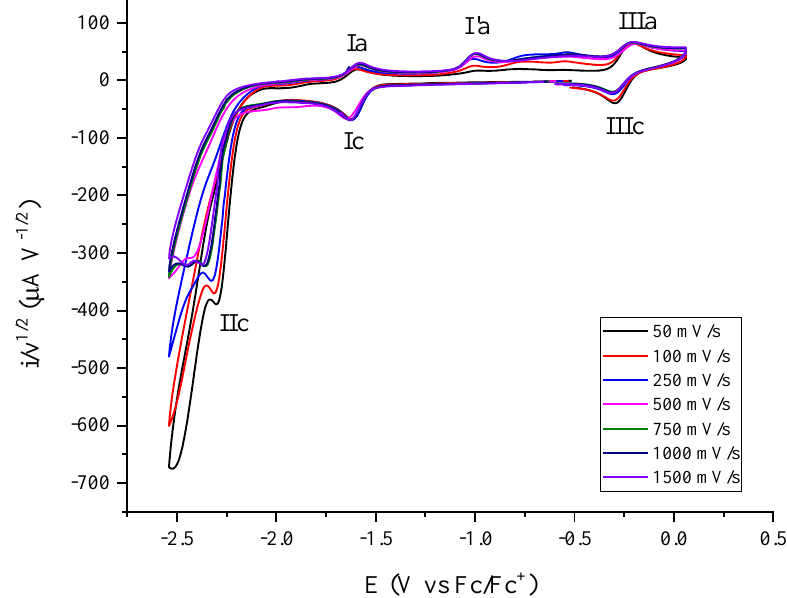
Figure 5. Normalized current cyclic voltammetry of 1 mM [Co II (phen) 3 ](BF 4 ) 2 solution in MeCN with 0.1 M of TBAPF 6 as supporting electrolyte, bubbled with CO 2 from open-circuit potential to cathodic direction. Glassy carbon disk as a working electrode.